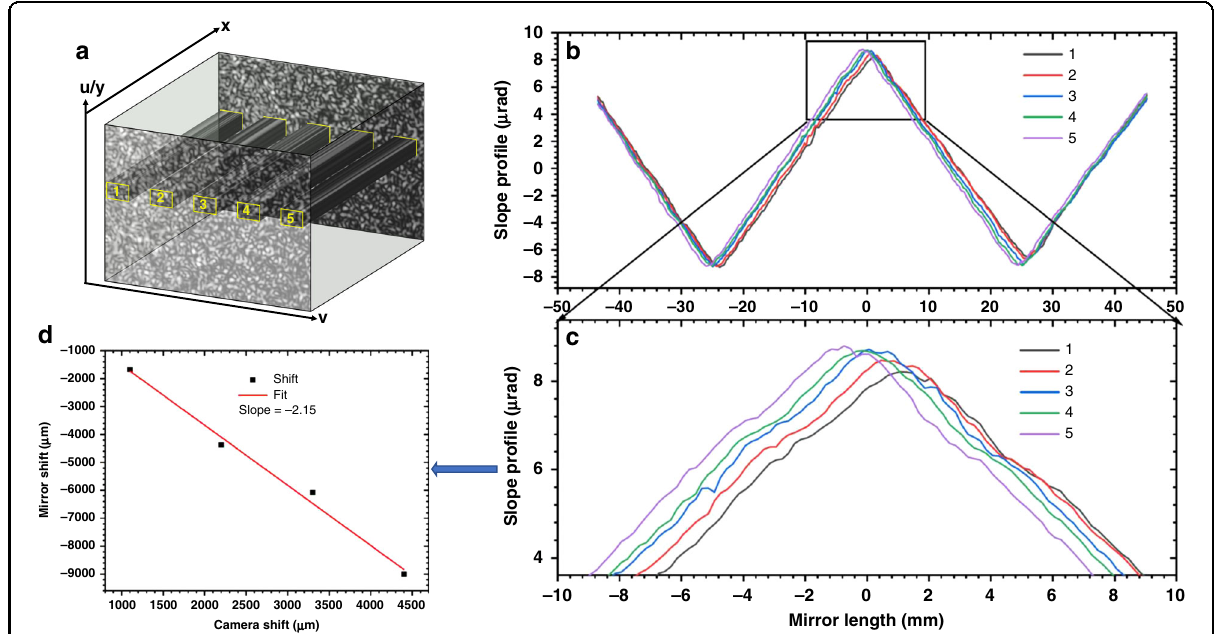
Fig. 6 Demonstration of calibration of spatial scaling factor. a Schematic representation of the scaling calibration, performed by choosing multiple subset windows at different vertical positions on the camera from a stack of speckle images. b The tangential mirror slope pro fi le of the elliptical mirror after subtraction of the best- fi t ellipse. c The zoomed region of ( b ), showing how the slope error pro fi le shifts with the subset window. d The line fi tting between the tracked position shift on the mirror and the subset window shift on the